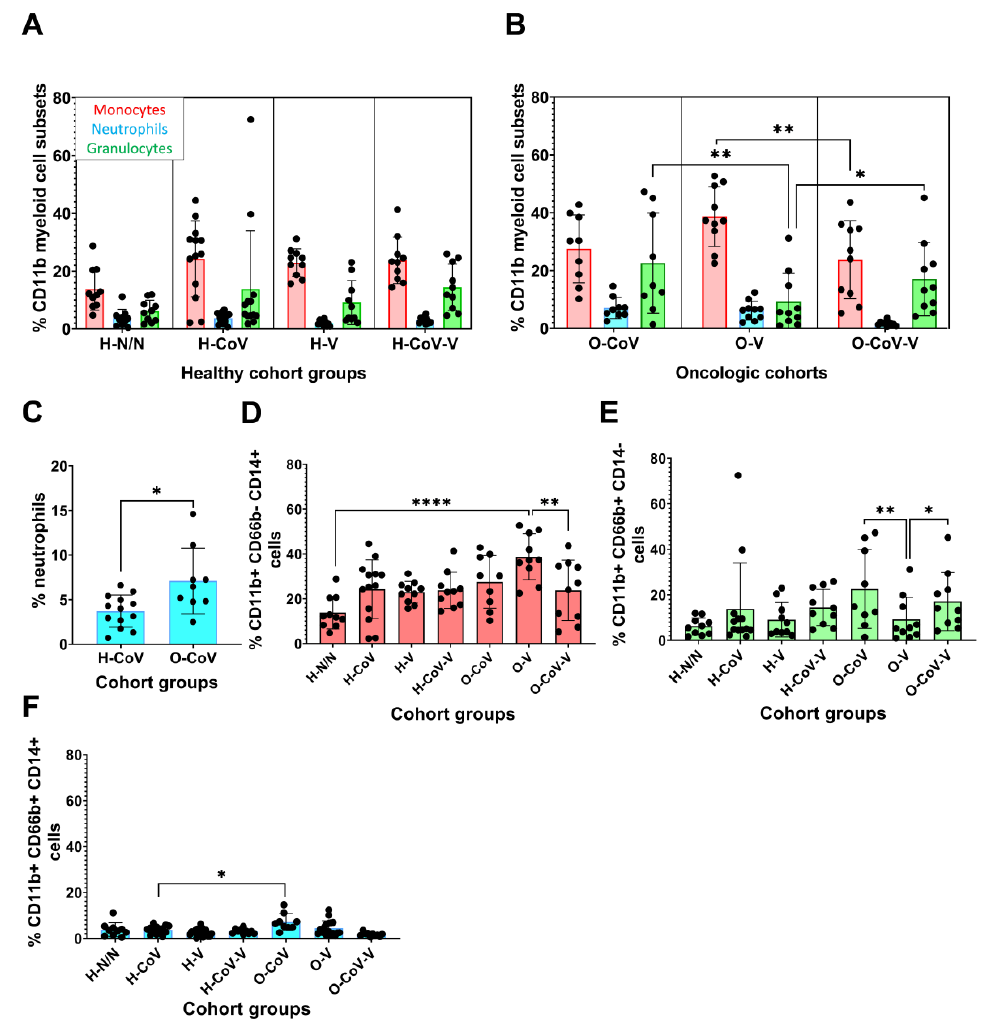
Figure 6. Systemic compositions of myeloid cell subsets. ( A , B ) Percentages of monocytes (CD11b + CD66b neg CD14 + ; red), neutrophils (CD11b + CD66b + CD14 + ; blue) and total granulocytes (CD11b + CD66b + CD14 neg , green), within CD11b + cells. ( C ) Percentage of neutrophils in H-CoV and O-CoV. ( D – F ) Percentages of monocytes (CD11b + CD66b neg CD14 + ), neutrophils (CD11b + CD66b + CD14 + ) and granulocytes (CD11b + CD66b + CD14 neg ) in the indicated groups. Statistical significance was evaluated by the Kruskal–Wallis test, followed by Dunn ´ s pair-wise comparisons.